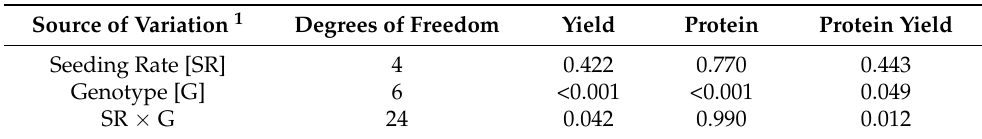
Table 5. Significance levels from ANOVA for yield, grain protein content, and protein yield combined across environments (location-year).